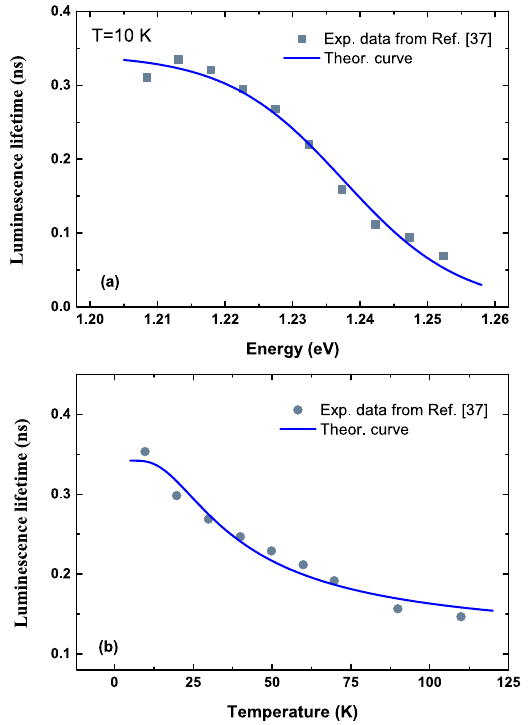
Figure 6. Luminescence lifetimes (solid symbols) of InGaAsN epilayer measured by Mair et al. for ( a ) different energy and ( b ) different temperatures 37 . The solid lines are the theoretical curves with Eq.